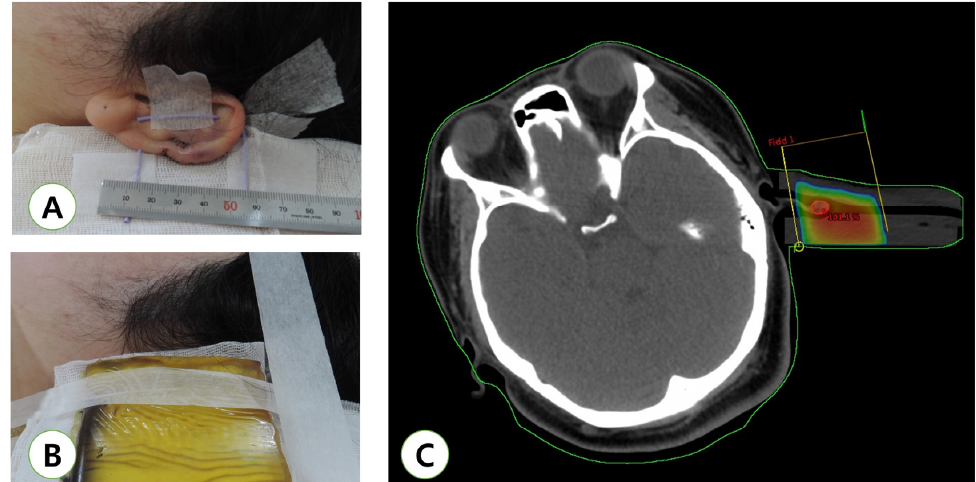
Figure 2. Example of adjuvant radiotherapy using a photon beam for an earlobe keloid. ( A ) Immediate post-operative view. ( B ) Simulation for radiotherapy. ( C ) Computed tomography-based treatment plan for an ear keloid.